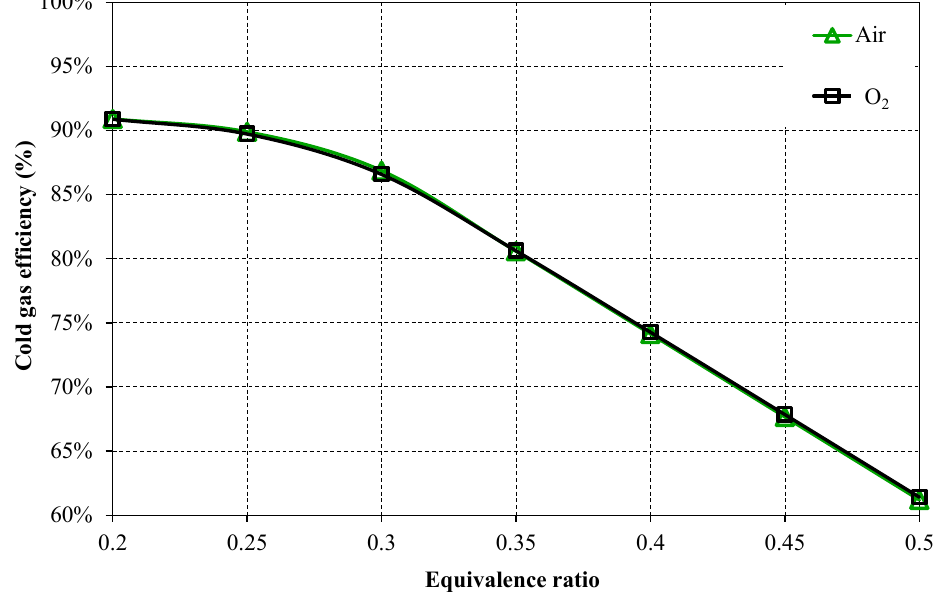
Figure 8. Cold gas efficiency.